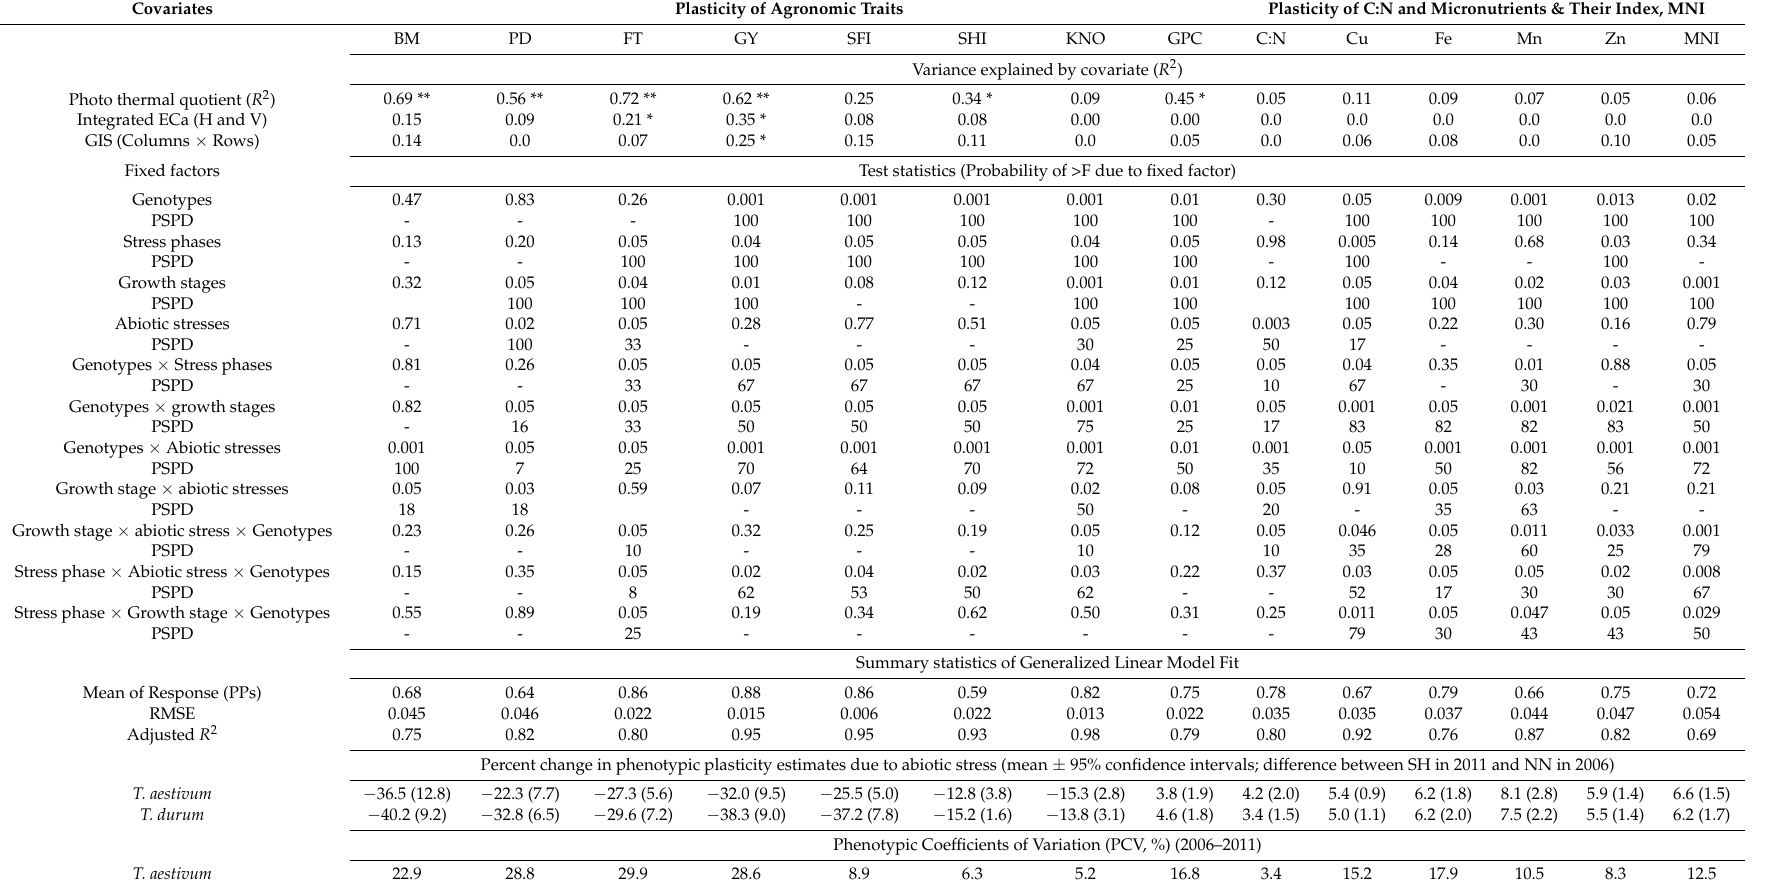
Table 2. Test statistics derived from results of a generalized linear model analysis, level of significance and percent significant pair-wise comparisons (PSPD); phenotypic, genotypic variance components and narrow sense heritability estimates of plasticity estimates of agronomic traits and micronutrients of T. aestivum and T. durum wheat genotypes attributed to fixed single factors and their interactions in a 6-year field study under three abiotic stress levels as compared to non-stress treatment (*, **, significant at the 5% and 1% level of probability, respectively, using Tukey’s